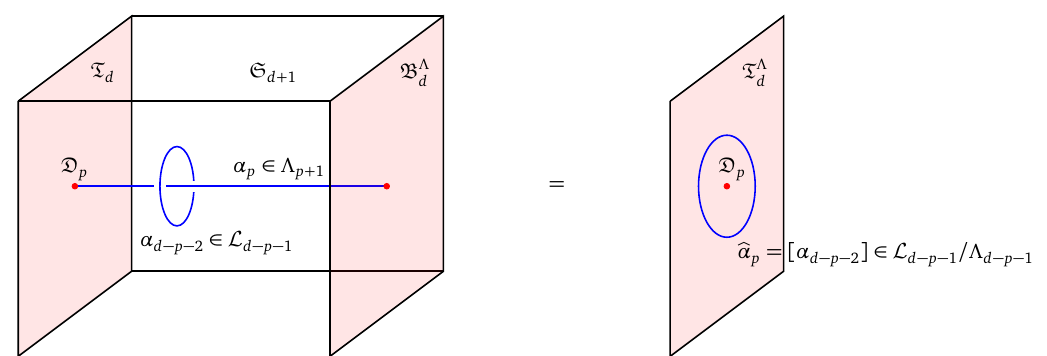
α on a genuine defect D (cid:98) p , where D d + 1